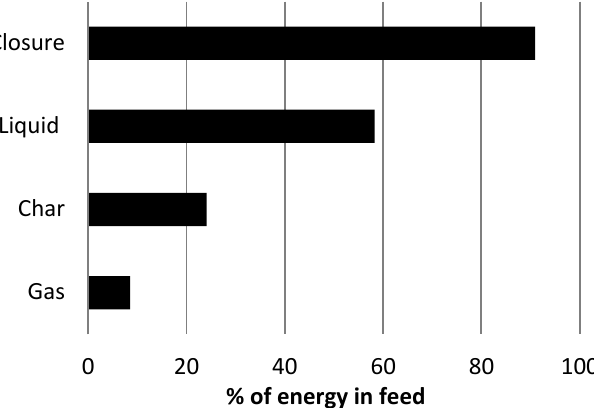
Figure 4. Energy balances as % of energy in feed for non-cataltyic pyrolysis of biomass.